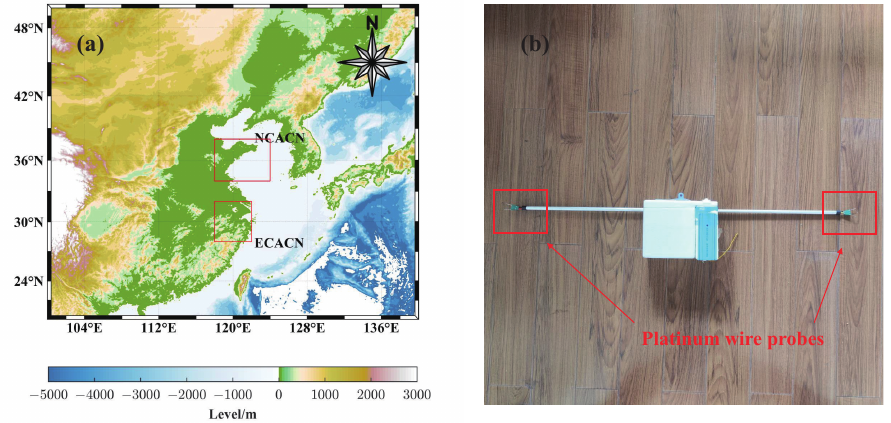
Figure 1. Field observation areas and instrument. ( a ) Sites locations: the eastern coastal area of China (ECACN) and the northern coastal area of China (NCACN). ( b ) Instrument: platinum wire probes (red rectangular